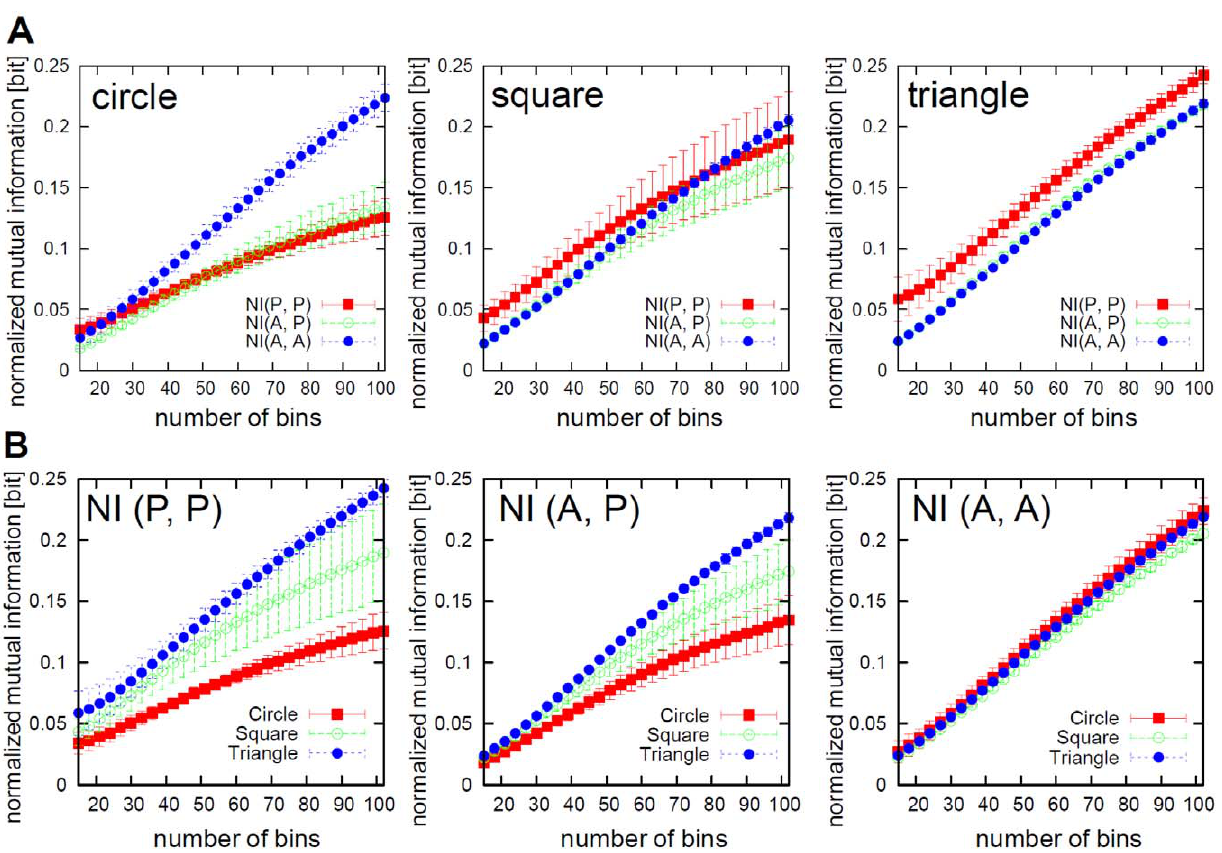
Figure 12. Comparisons of normalized mutual information according to the number of bins. A. Comparisons of normalized mutual information ( NI ( P , P ) , NI ( A , P ) , and NI ( A , A ) ) according to the number of bins in the circular (left), square (middle), and triangular (right) cases. B. Comparisons of the circular, square and triangular cases for NI ( P , P ) , NI ( A , P ) , and NI ( A , A ) . The same plots of A. are rearranged.